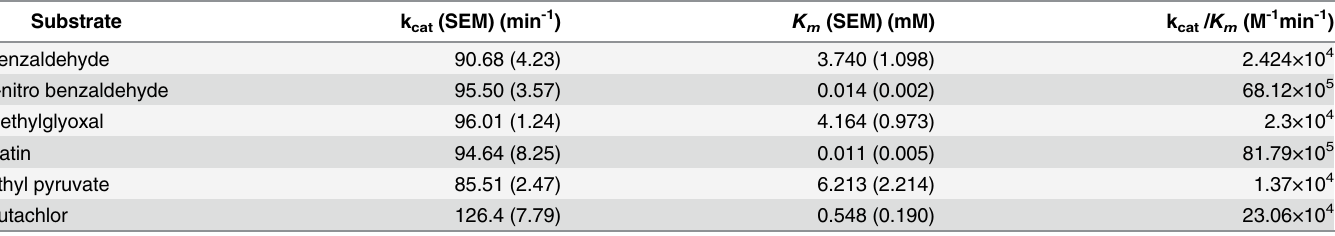
Table 1. Steady-state kinetic parameters of recombinant His-tagged AKR17A1. Kinetic constants are mean values of three independent experiments. Values in parentheses indicate standard error of the mean (SEM). The activity of AKR17A1 at various concentrations of substrates tested is given as Fig C in S3